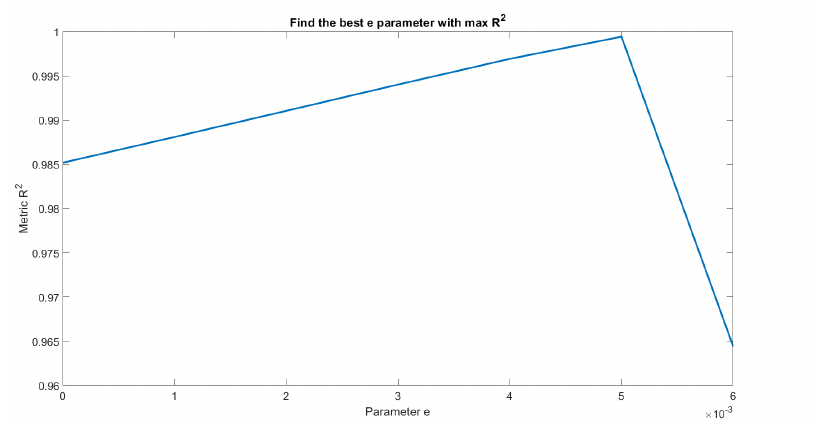
Figure 11. Example of a graphical representation of the iteration result. Value of e is varied from a minimum to a maximum value and is taken as the value that maximizes R 2 in the segment under